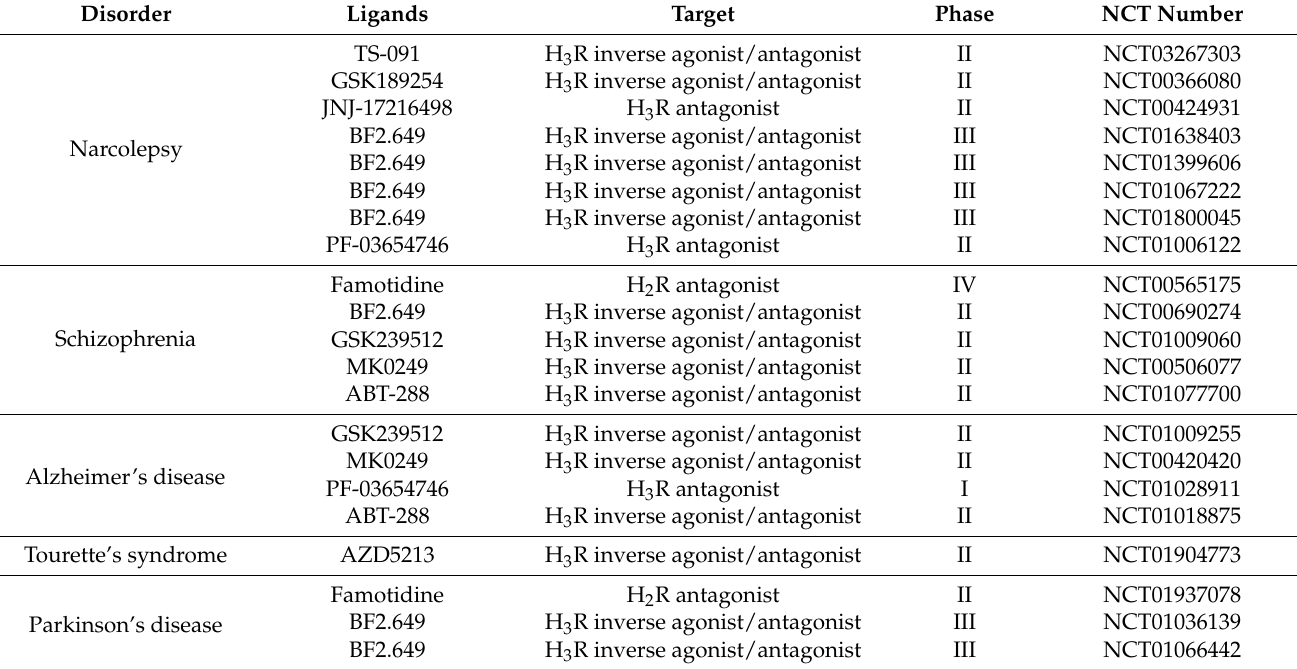
Table 1. Histamine receptors ligands in clinical trials for the treatment of neuropsychiatric disorders.